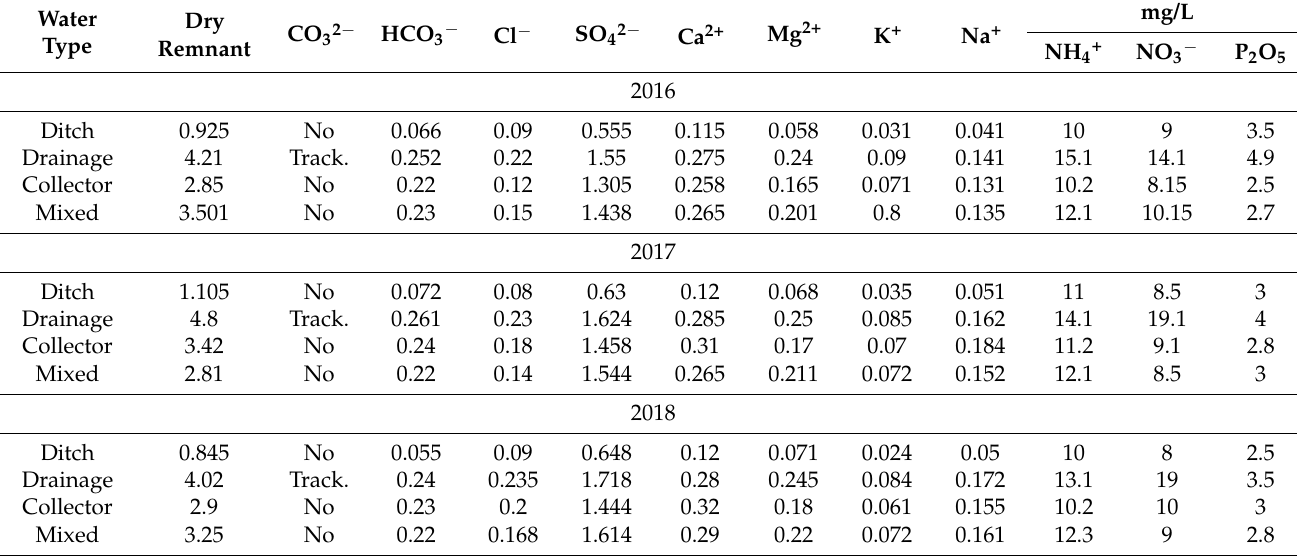
Table 4. Average chemical compositions of irrigation water sources